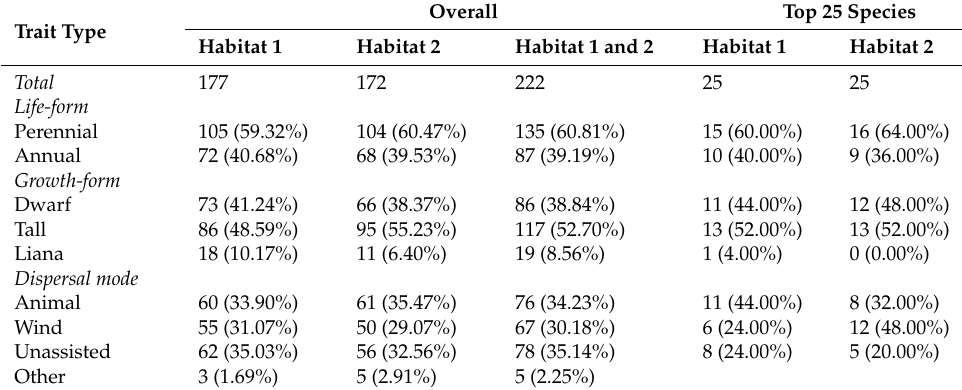
Table 1. Species richness of each functional trait type in the two kinds of habitats.